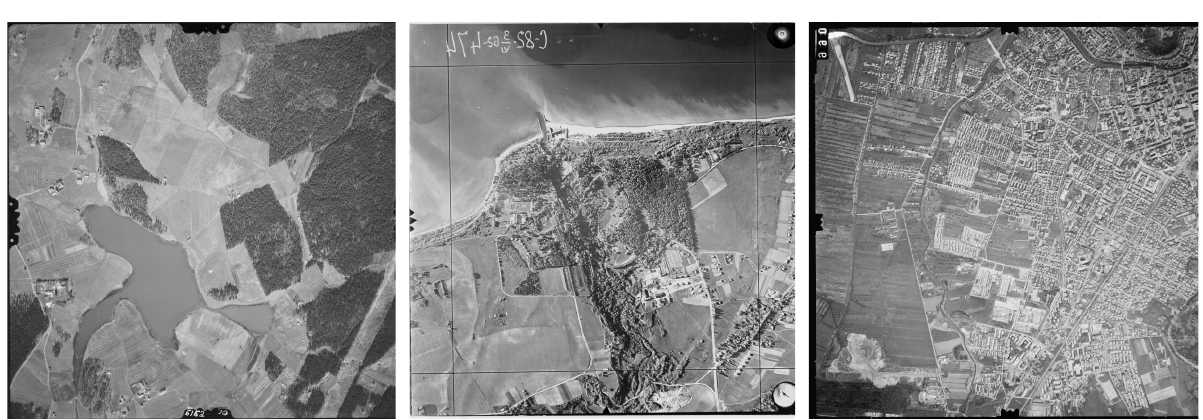
Figure 1. Examples of historical aerial images collected for the TIME benchmark. Finland – 1951 (left); Estonia – 1962 (middle); Slovenia – 1979